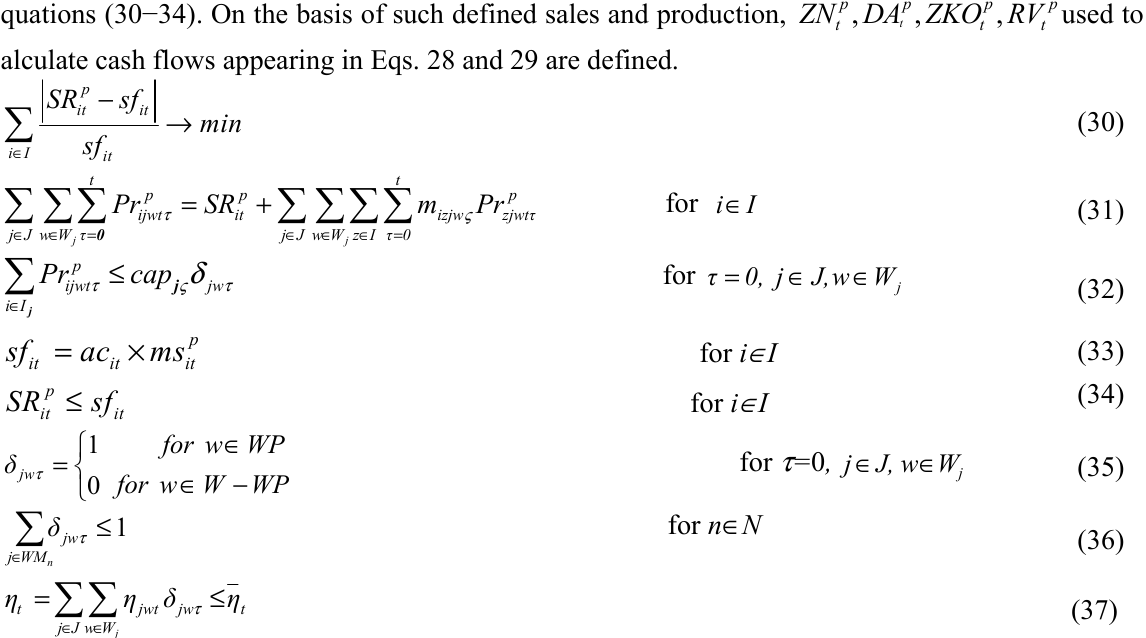
Investment outlay, thousand USD (Average, standard